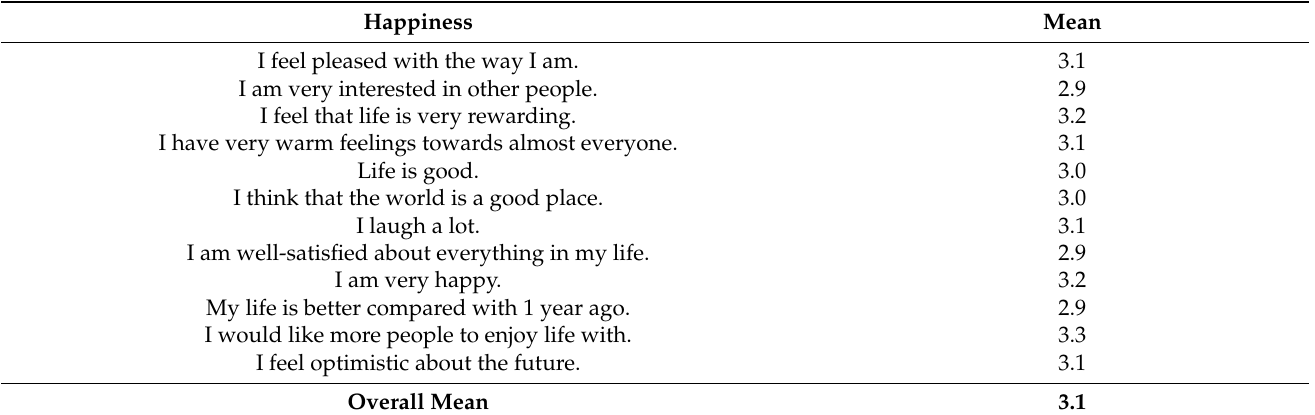
Table 2. Mean of responses to the happiness of care home residents. Happiness